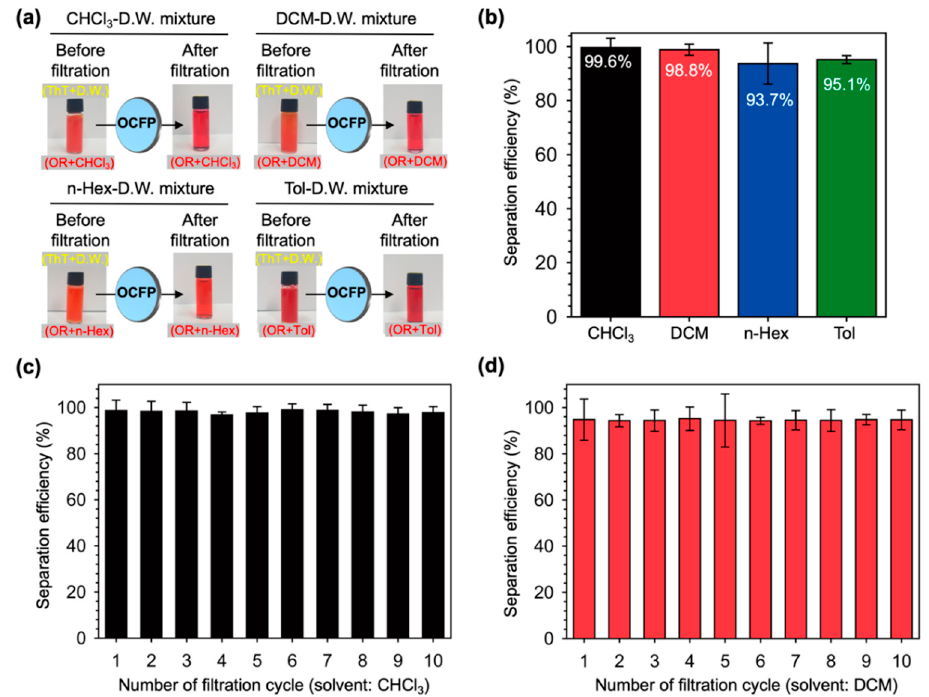
Figure 4. The oil-water separation efficiency of OCFP. ( a ) Representative photographs of wet organic solvents; chloroform (CHCl 3 ), dichloromethane (DCM), n-hexane (n-Hex), toluene (Tol) (with 0.01% Oil red O), and D.W. (with 0.01% Thioflavin T) before OCFP filtration (left) and dry organic solvents after OCFP filtration (right). ( b ) The separation efficiency of OCFP for CHCl 3 , DCM, n-Hex, and Tol. Recyclability efficiency of OCFP for ( c ) chloroform (CHCl 3 ) and ( d ) dichloromethane (DCM) over 10